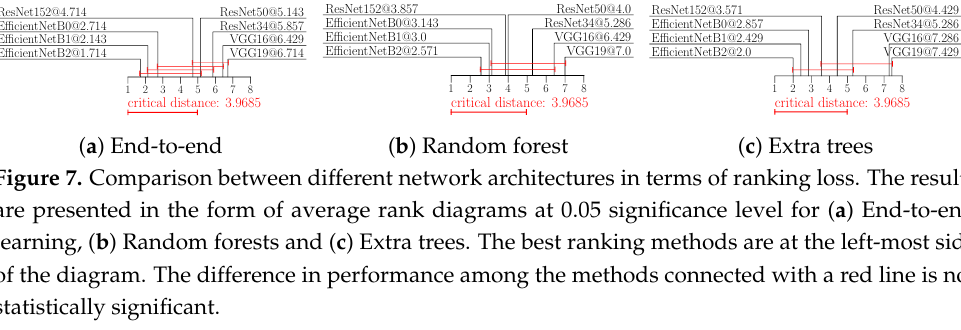
EfficientNetB2@2.571EfficientNetB1@3.0EfficientNetB0@3.143ResNet152@3.857 VGG19@7.0VGG16@6.429ResNet34@5.286ResNet50@4.0